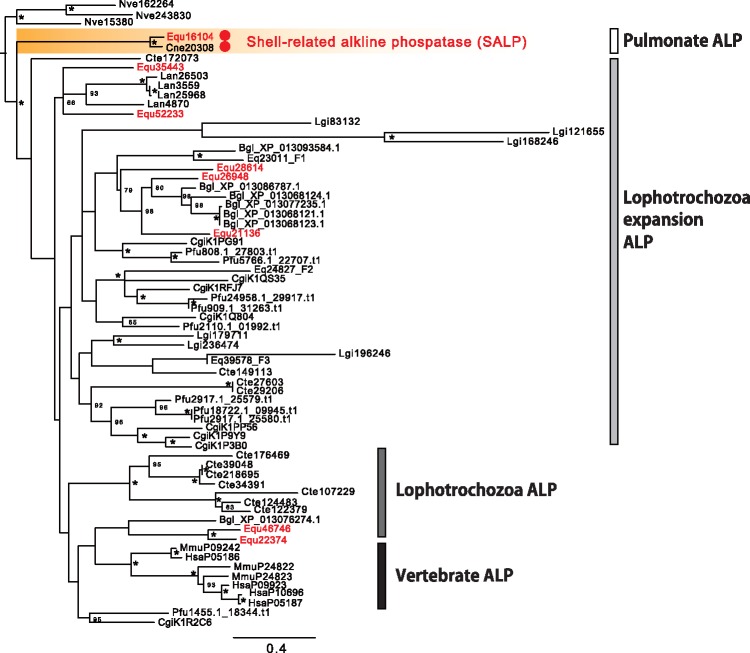
—Phylogeny of alkaline phosphatase (ALP) in various metazoan taxa. The maximum likelihood tree was inferred from 67 alkaline phosphatase gene sequences under the WAG + Γ model (250 positions of the ALK_phosphatase domain, 100 bootstrap replicates). Bootstrap support values <50% are not shown. Asterisks indicate 100% bootstrap support. Branch lengths are proportional to the expected number of substitutions per site, as indicated by the scale bar. Red circles indicate proteins that have been identified as SMPs in this or previous studies. Aca, Aplysia california; Bgl, Biomphalaria. glabrata; Cgi, Crassostrea gigas; Cne, Cepaea nemoralis; Cte, Capitella teleta; Equ, Euhadra quaesita; Hsa, Homo sapiens; Lan, Lingula anatina; Lgi, Lottia gigantea; Mmu, Mus musculus; Nve, Nematostella vectensis; Pfu, Pinctada fucata.